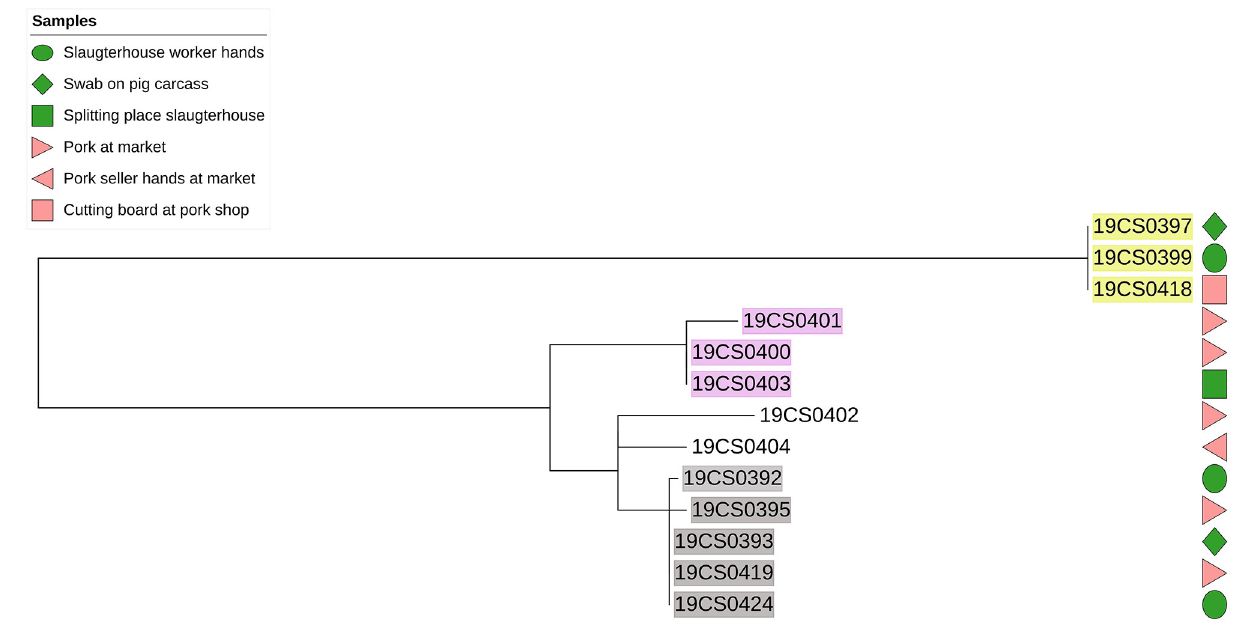
FIGURE 2 | Phylogenetic SNP-based tree of S. Derby strains. Samples highlighted in different colors: clusters with more than one isolate. Green color figure: slaughterhouse samples, pink color figures: market samples.